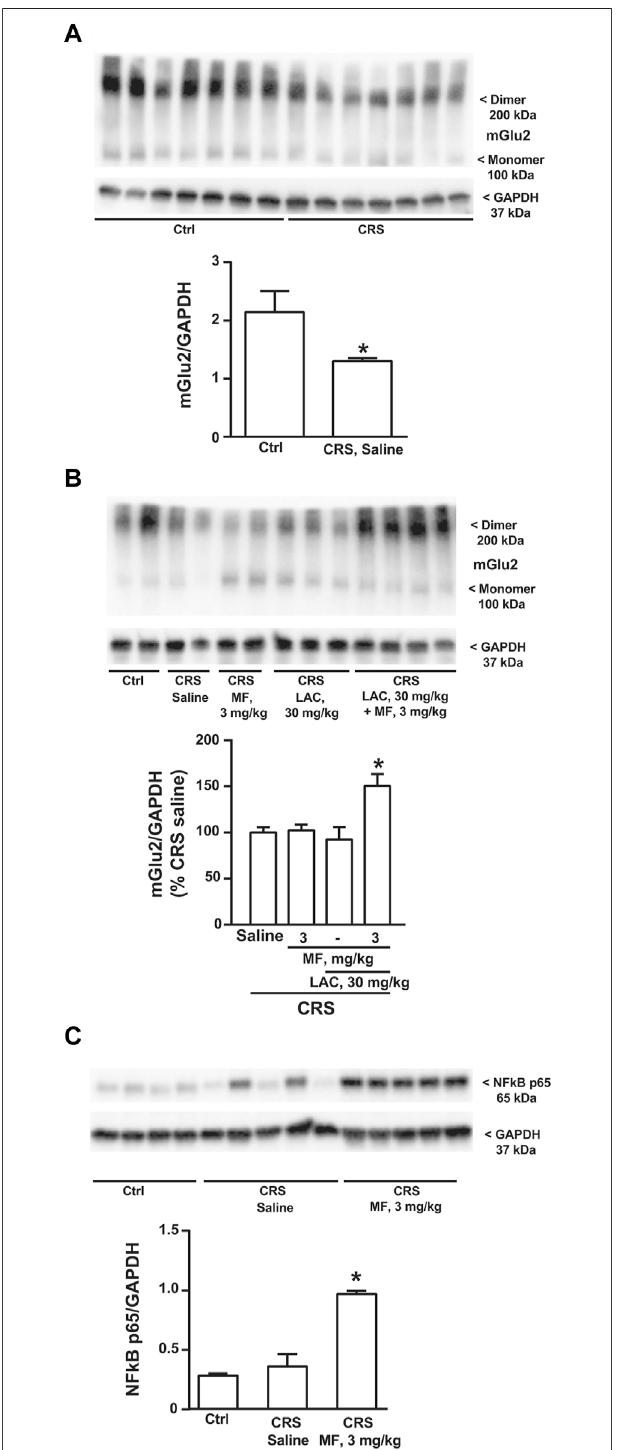
FIGURE 4 | Immunoblot analysis of mGlu2 receptor and NF κ B p65 proteinlevelsinthehippocampus.mGlu2proteinlevelsinthehippocampusof CRS mice treated with saline and unstressed controls (Ctrl) are shown in (A) ; mGlu2 protein levels in the hippocampus of CRS mice treated i.p. with saline, MF (3 mg/kg), LAC (30 mg/kg) or their combination are shown in (B) ,